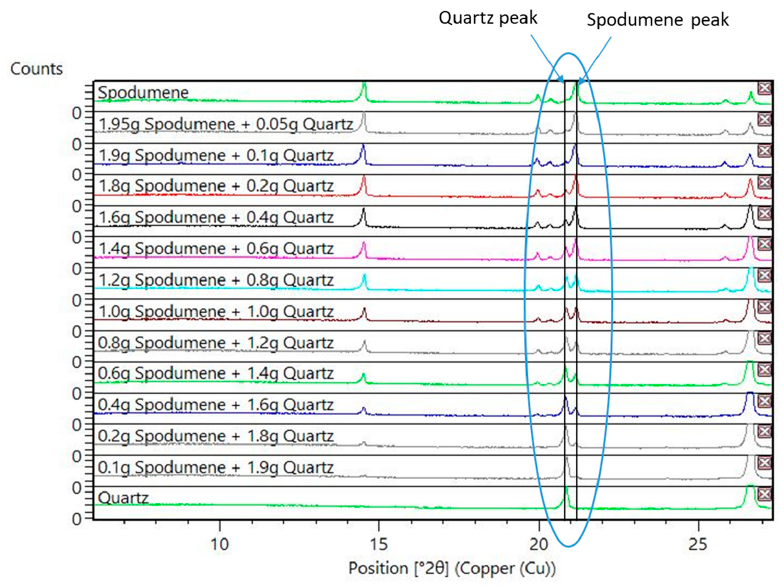
Figure 7. XRD patterns of different spodumene–quartz mixtures (main peak of quartz and spodumene highlighted).